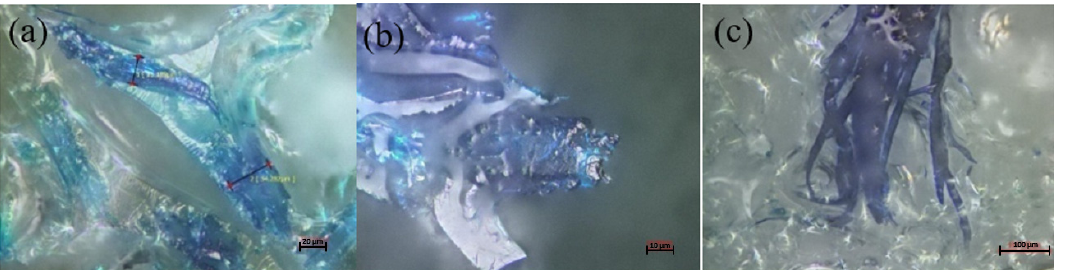
Figure 7. Microscopic observation of wood fiber-matrix interaction: ( a , b ) single fibers, ( c ) fiber agglomeration.